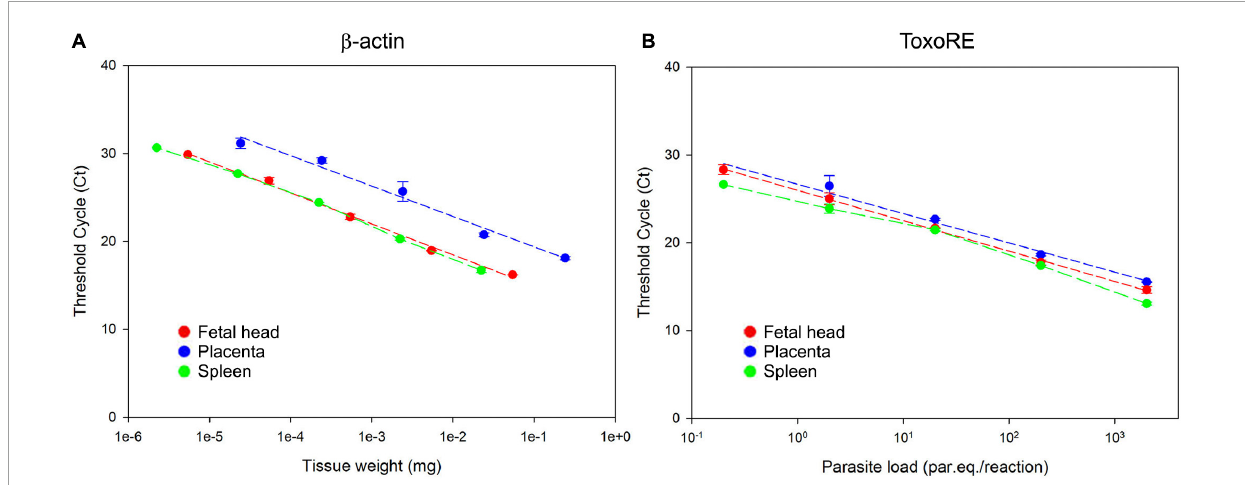
FIGURE5 Dynamic range of T. gondii detection in fetal (E13.5–14.5) and maternal tissues. (A) Standard curve for the β -actin target in fetal head, placenta, and spleen. Ten-fold serial dilutions of different tissues were used to generate the β -actin curves, indicating the linearity of the reaction. (B) Standard curve for the ToxoRE target in fetal head, placenta, and spleen. Ten-fold serial dilutions of tachyzoites spiked into tissues were used to generate DNA curves with dynamic ranges of 10 5 to 10 par.eq./reaction for each